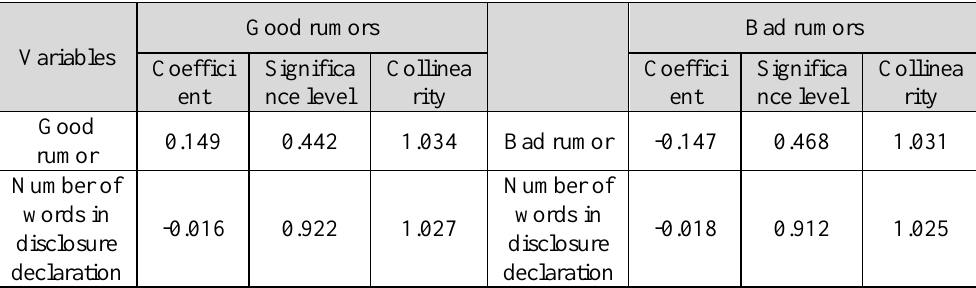
Table 7. Final estimation of the regressive model in the first major hypothesis (Good and bad rumors with abnormal return within 22 days